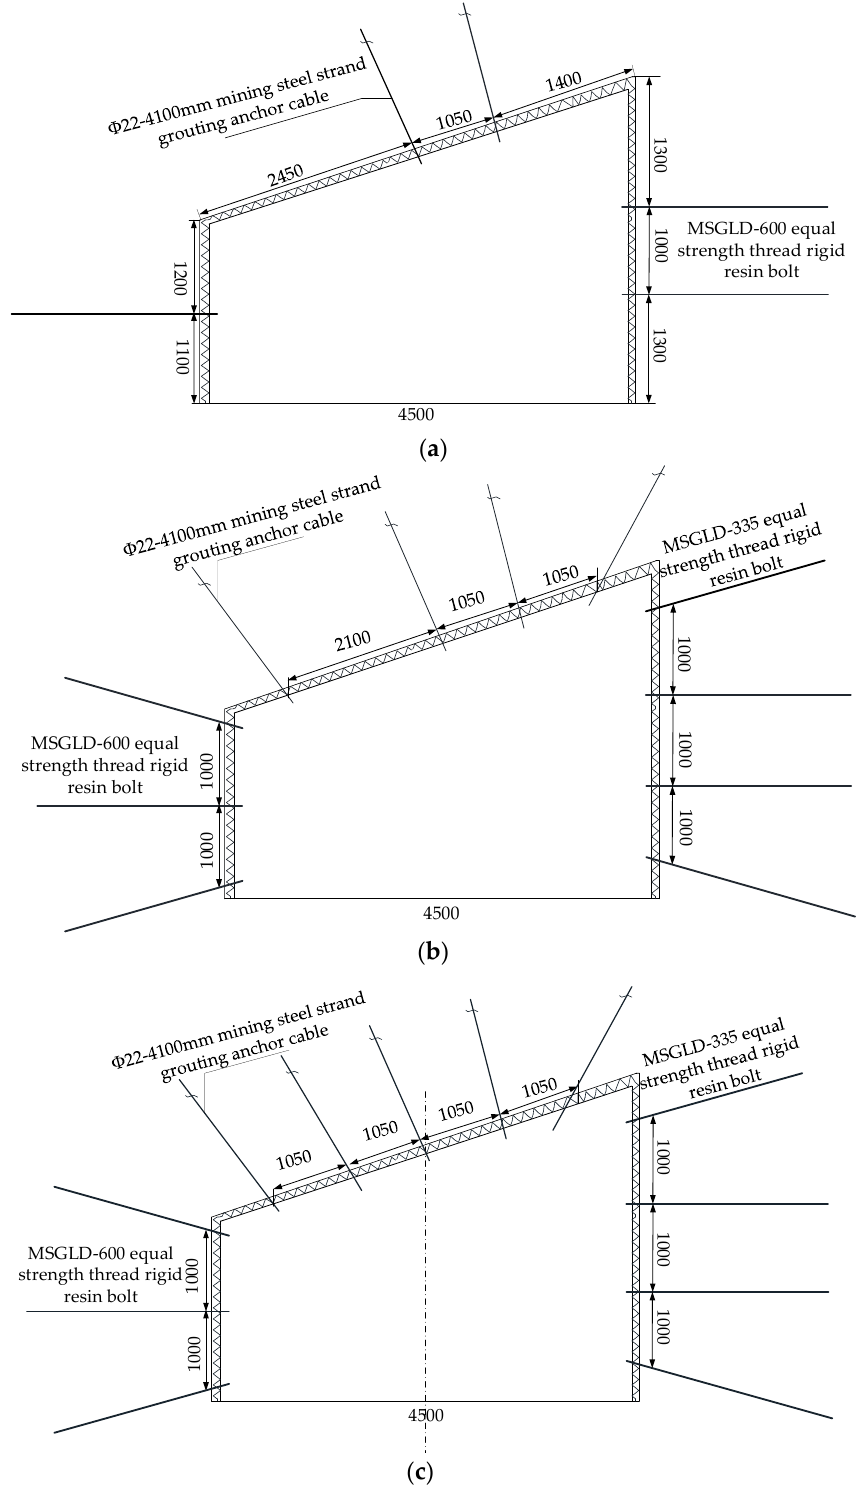
Figure 4. Tertiary support sectional drawing: ( a ) primary support, ( b ) secondary support, ( c ) tertiary support.